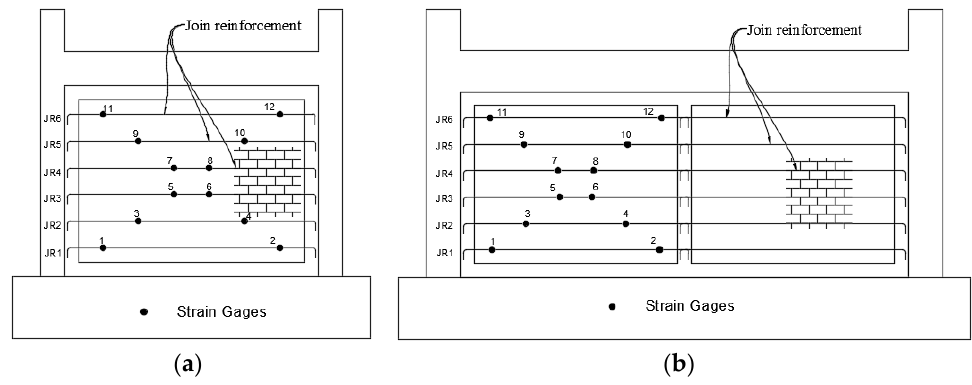
Figure 7. Internal instrumentation. ( a ) specimens MD3NRH_L75, ( b ) specimens MD3NRH_L41.